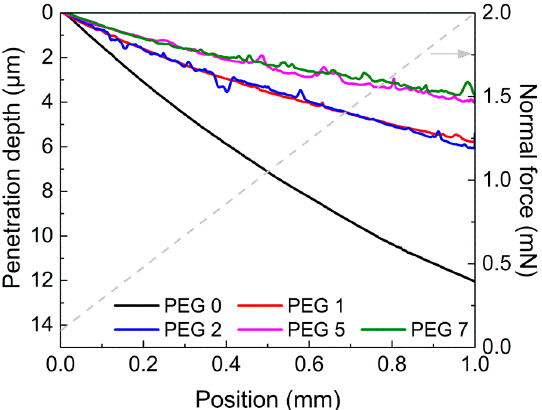
Figure 7. Penetration depth profiles for the cured hydrogel films with different portions of G-SiNPs.